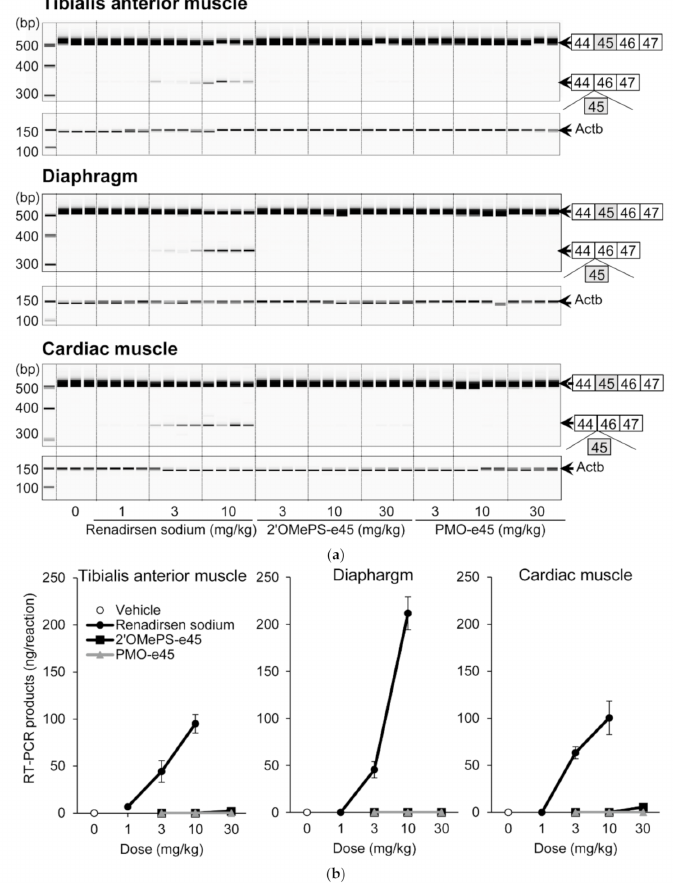
Figure 5. Effects of renadirsen sodium, 2 (cid:48) OMePS-e45, and PMO-e45 on dystrophin exon 45 skipping in mdx muscles. ( a ) Detection of exon-45-skipped RT-PCR products of dystrophin mRNA in various muscles from mdx mice after systemic delivery of renadirsen sodium, 2 (cid:48) OMePS-e45, or PMO-e45. Each compound was injected subcutaneously into mdx mice once a week for 4 weeks. Total RNA was isolated from the tibialis anterior muscle, diaphragm, and cardiac muscle. The structure of each PCR product is shown schematically at the right of the panel. ( b ) The concentrations of exon-45-skipped RT-PCR products of dystrophin mRNA from the tibialis anterior muscle, diaphragm, and cardiac muscle were calculated using an Agilent 2100 Bioanalyzer. Data in (B) are shown as means ± SEM; n =